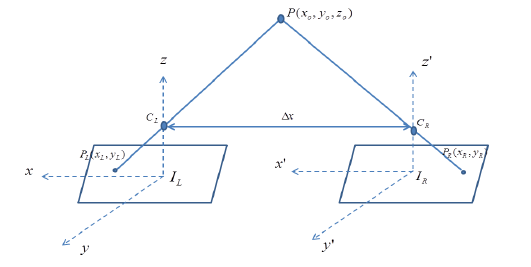
Figure 2. Stereo camera model ( Boyer, 1988